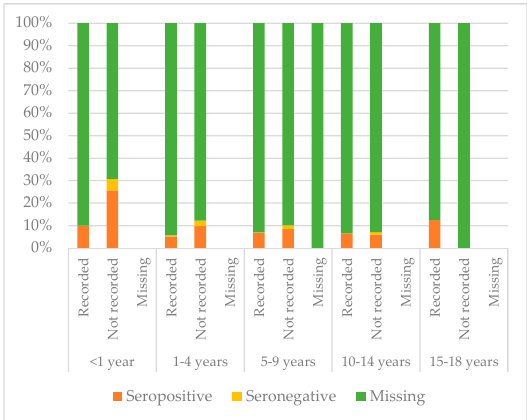
Figure 7. Comparison between immunisation status of IAC reported in the documentation and serology for hepatitis B, by continent of origin (Table A4 in the Appendix).